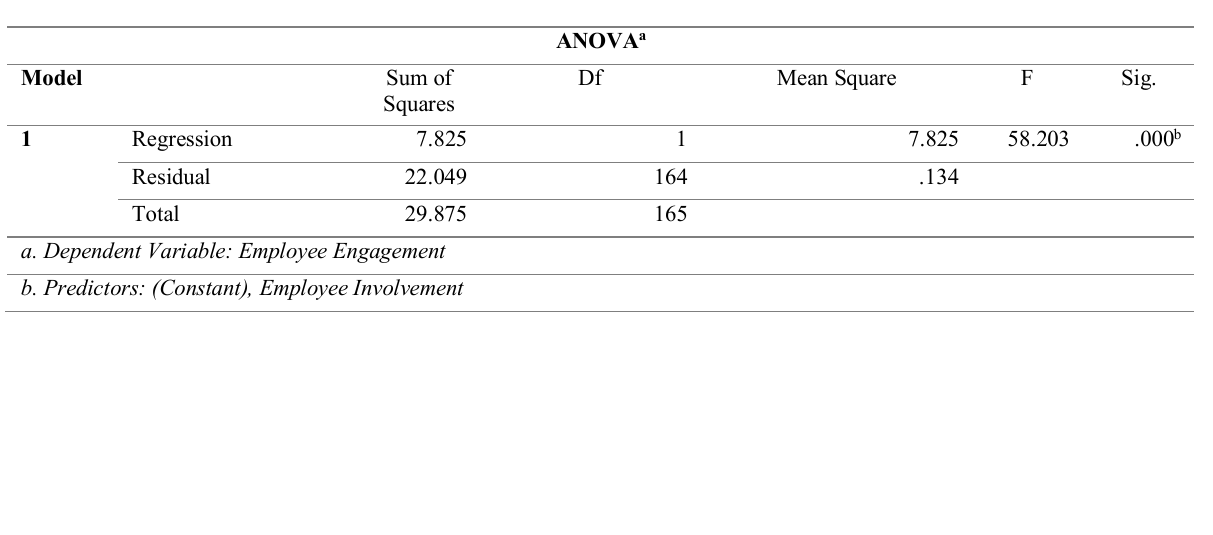
Table 4 (b ): Regression ANOVA for Employee Involvement and Employee